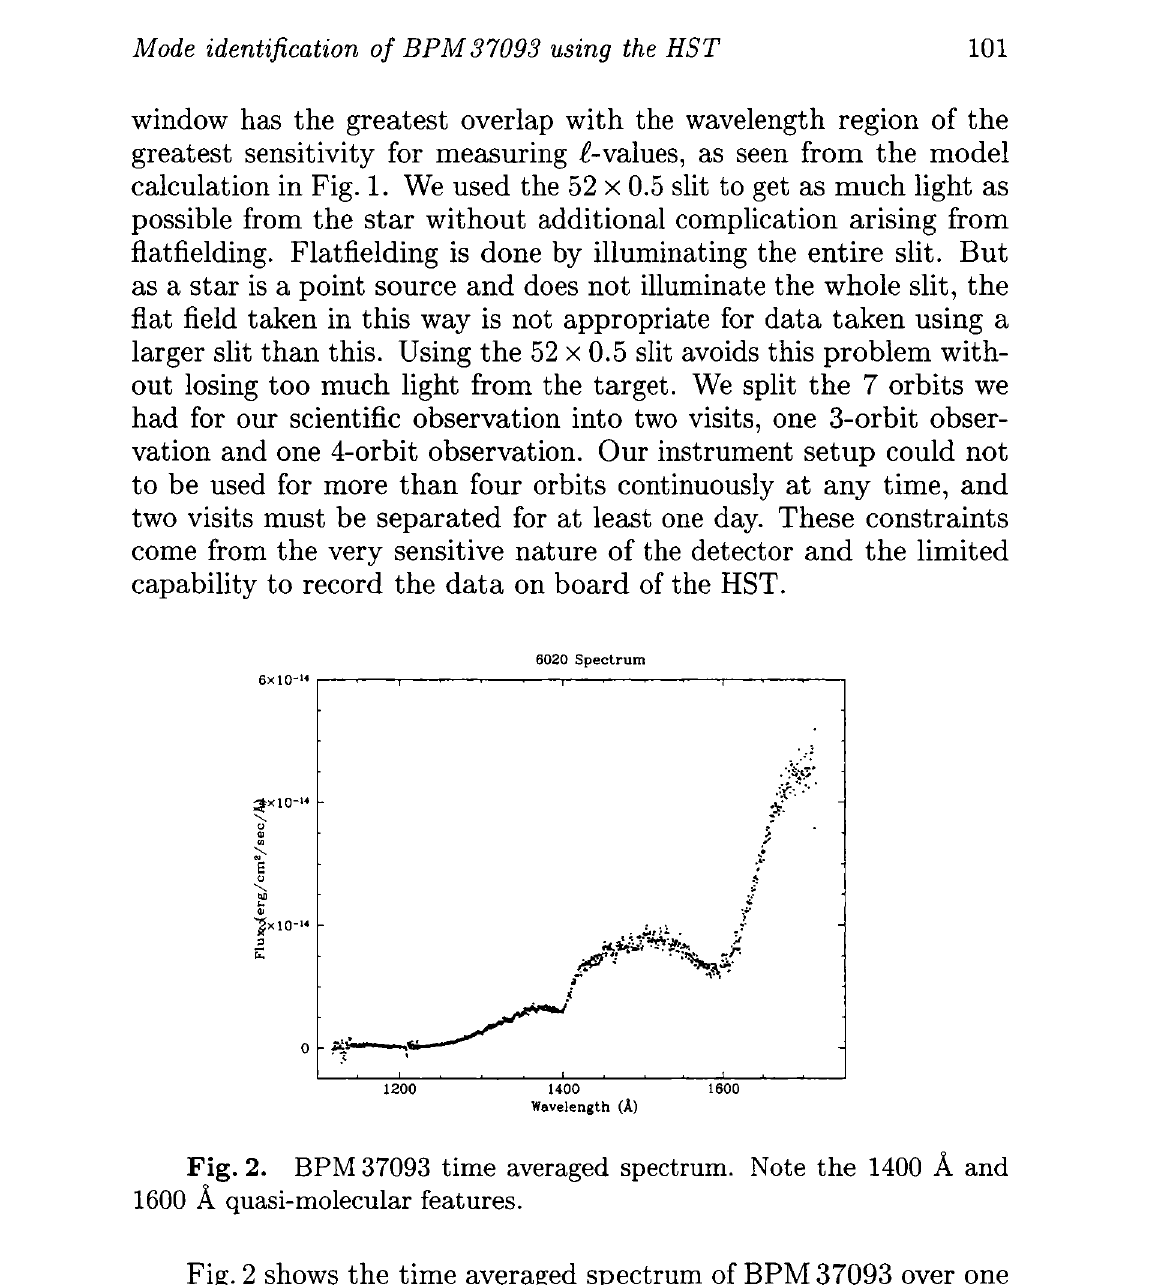
Fig. 2. BPM 37093 time averaged spectrum. Note the 1400 A and 1600 A quasi-molecular